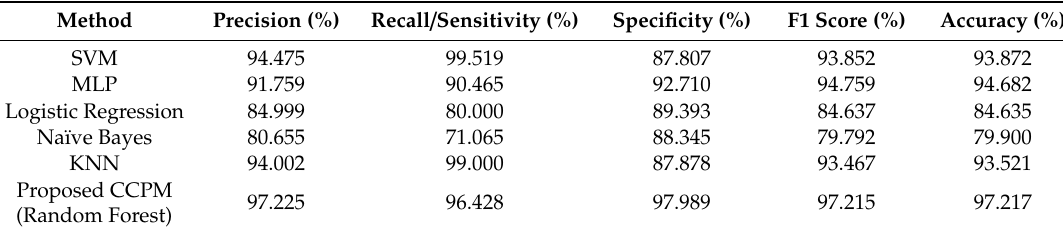
Table 18. Performance evaluation results based on DBSCAN and SMOTE for Cytology.